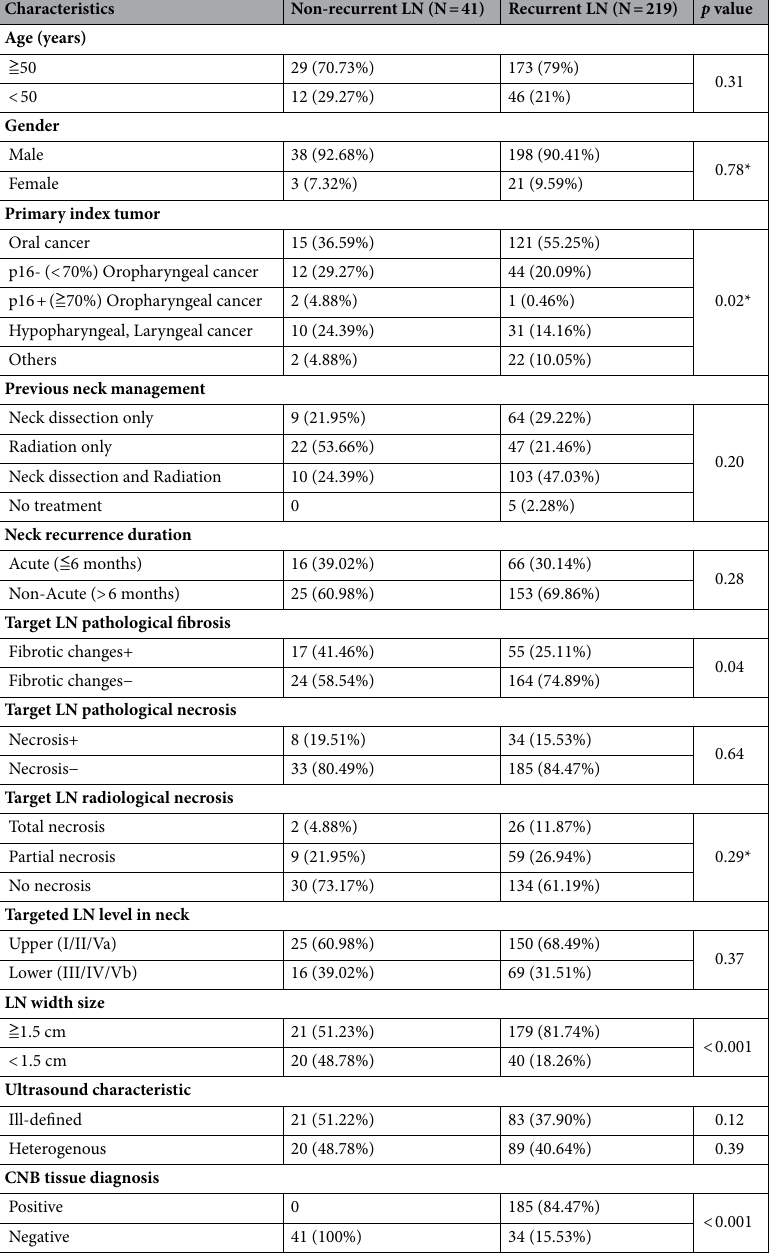
Table 1. Basic, clinicopathologic and ultrasound characteristics of treated head and neck SCC patients with recurrent LN. SCC, squamous cell carcinoma; LN, lymph node. *Using Fisher’s exact